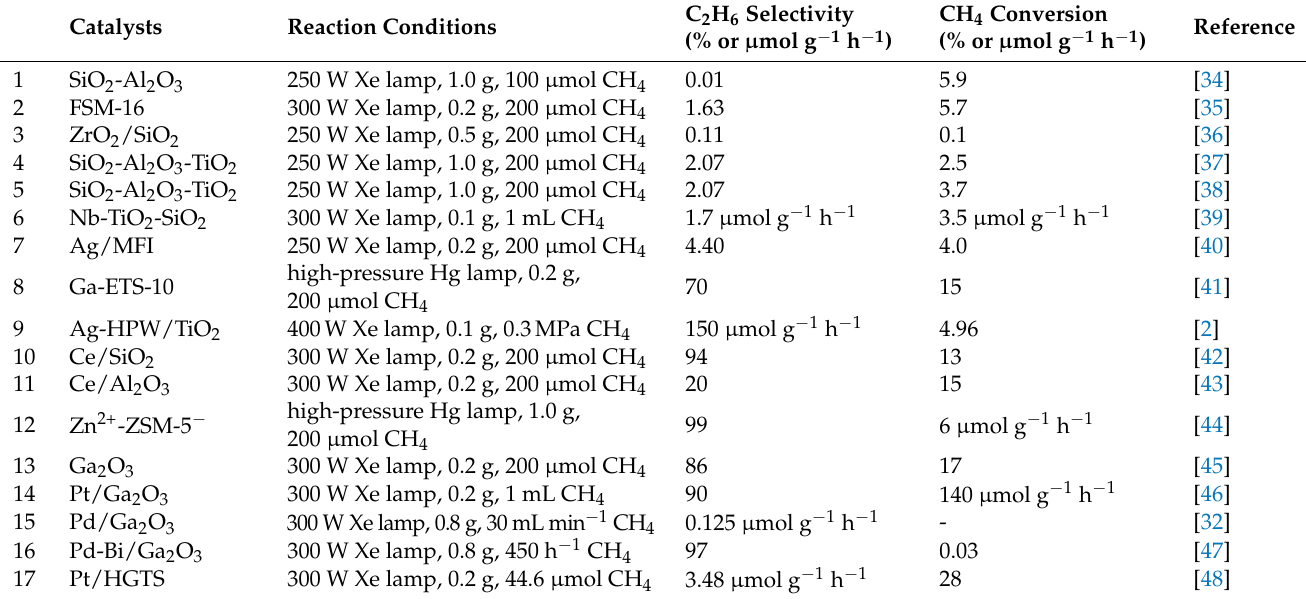
Table 2. C 2 H 6 selectivity and CH 4 conversion in photocatalytic NOCM using different